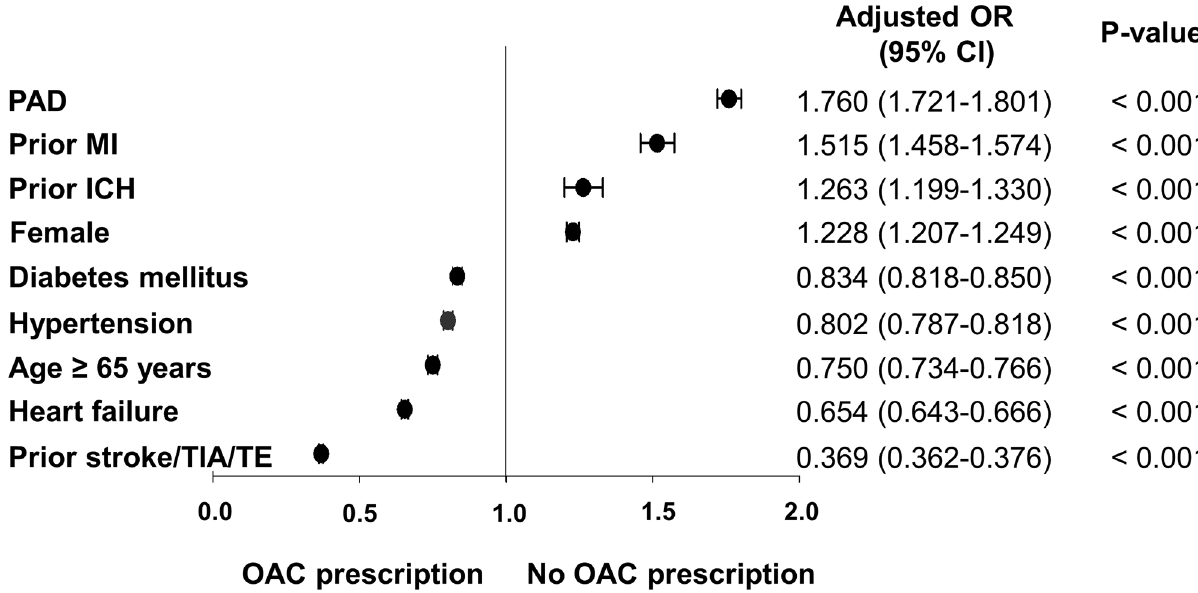
Fig 4. Factors associated with OAC underuse. Abbreviation: CI, confidenceinterval; ICH, intracranialhemorrhage; MI, myocardial infarction; OR, odds ratio; PAD, peripheral artery disease;TIA, transient ischemic attack; TE, systemic thromboembolism.